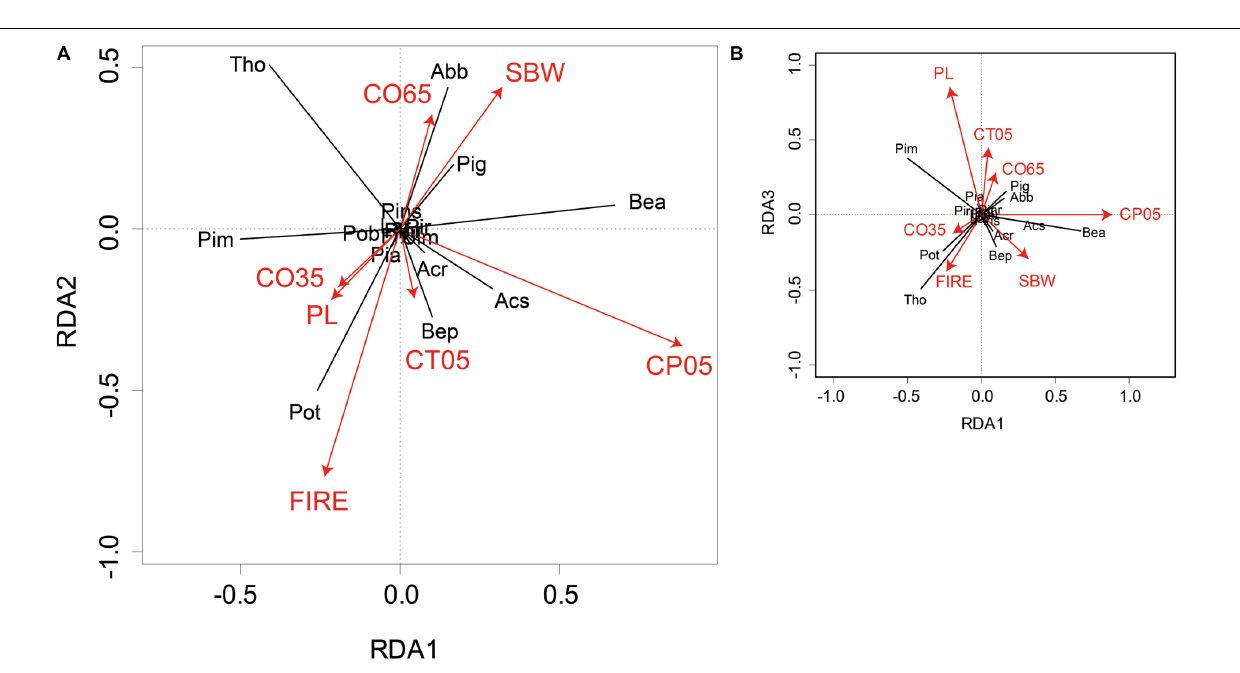
Frontiers in Ecology and Evolution |